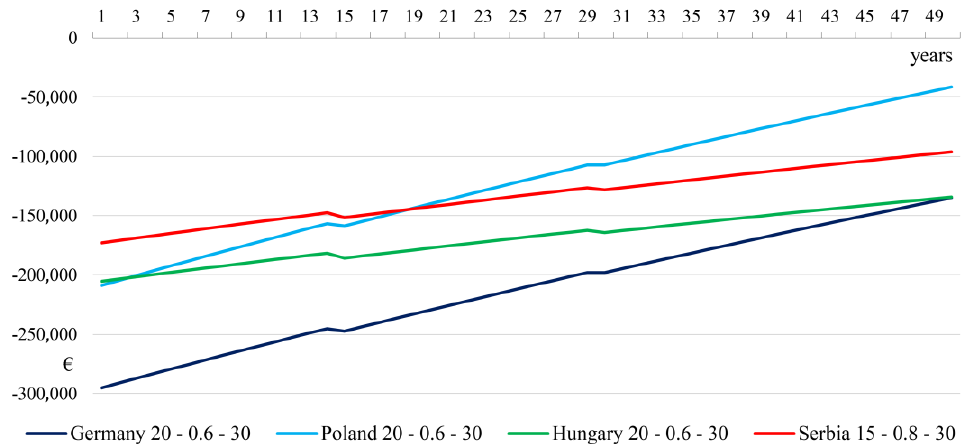
Figure 8. Results of NPV analysis for optimal scenarios without incentives (d = 3.5%, energy price rise 2% per year).